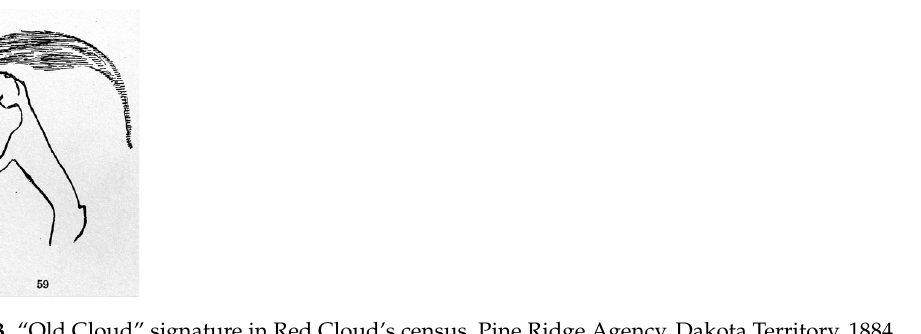
Figure 24. Picture-writing image for “old” reimagined by Tomkins for his Boy Scout monograph (Publ. in Tomkins 1926).